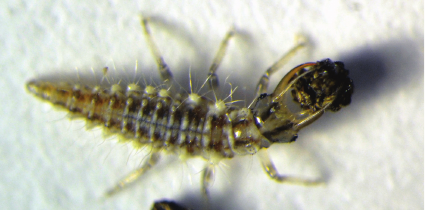
Figure 2: Larva of Chrysoperla carnea (Stephens, 1836) uplifting an egg of Cryptocephalus rufipes (Goeze, 1777).